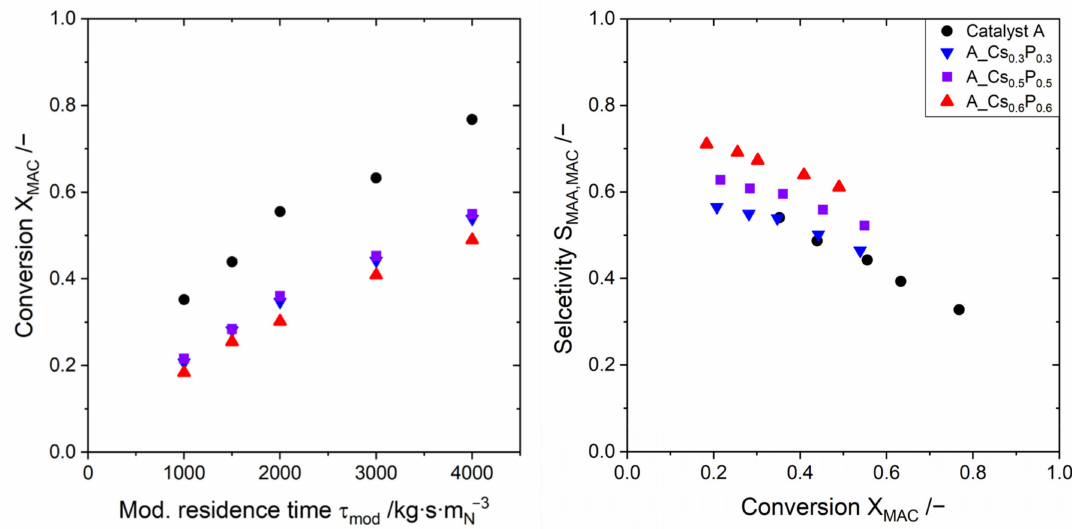
Figure 7. Catalytic performance of catalyst A prior to and after adding Cs and P. Variation of the (Mo + V + W)/P ratio with constant Cs/P ratio of 1 at 300 ◦ C and 21% v/v water. MAC conversion over modified residence time ( left ) and MAA selectivity over conversion ( right